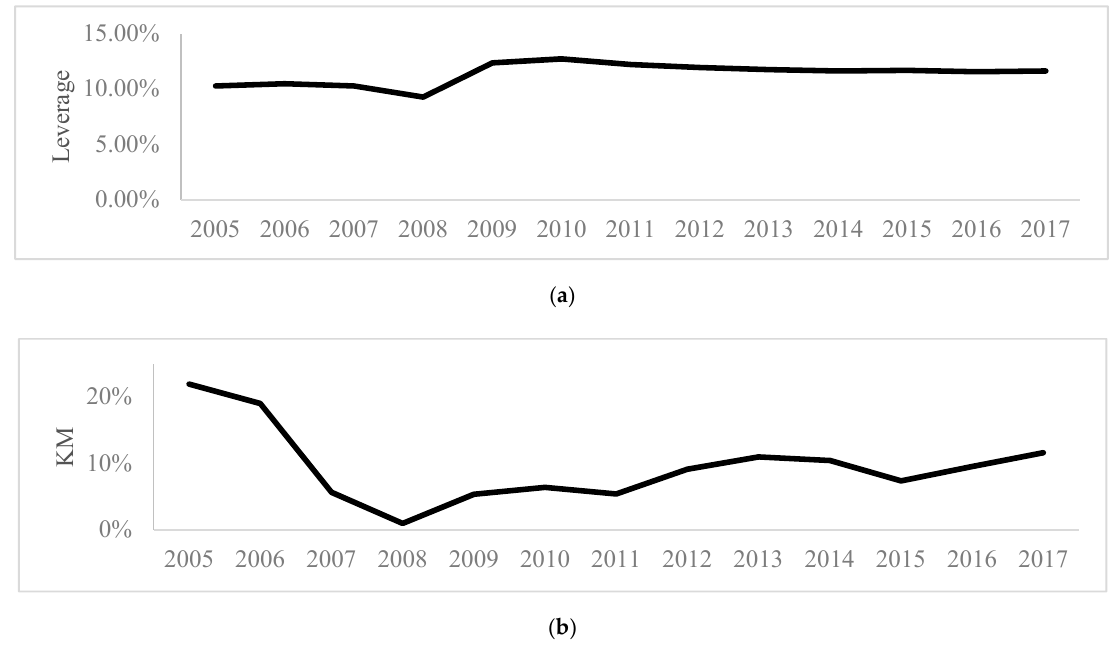
Figure 4. ( a ) Leverage Trend; ( b ) Market Value of Capital (KM) Trend.